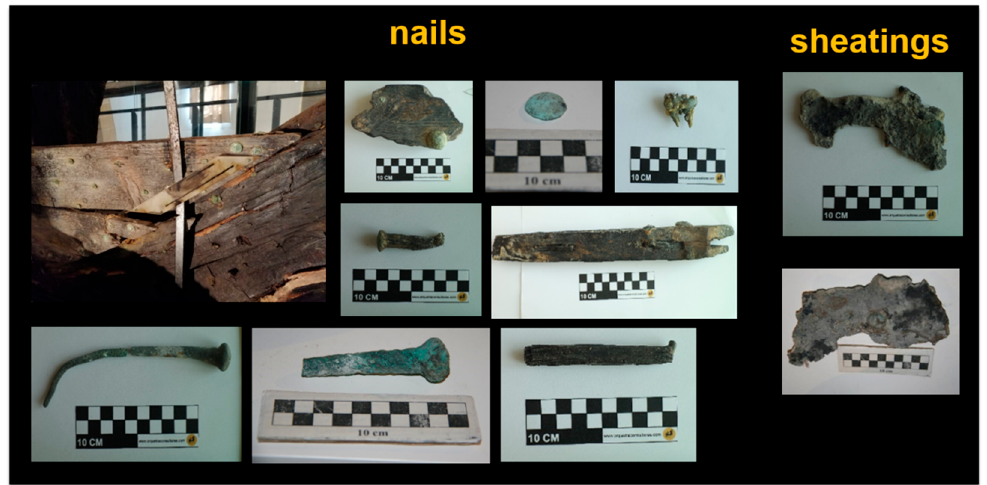
Figure 2. Photos of some investigated nails and